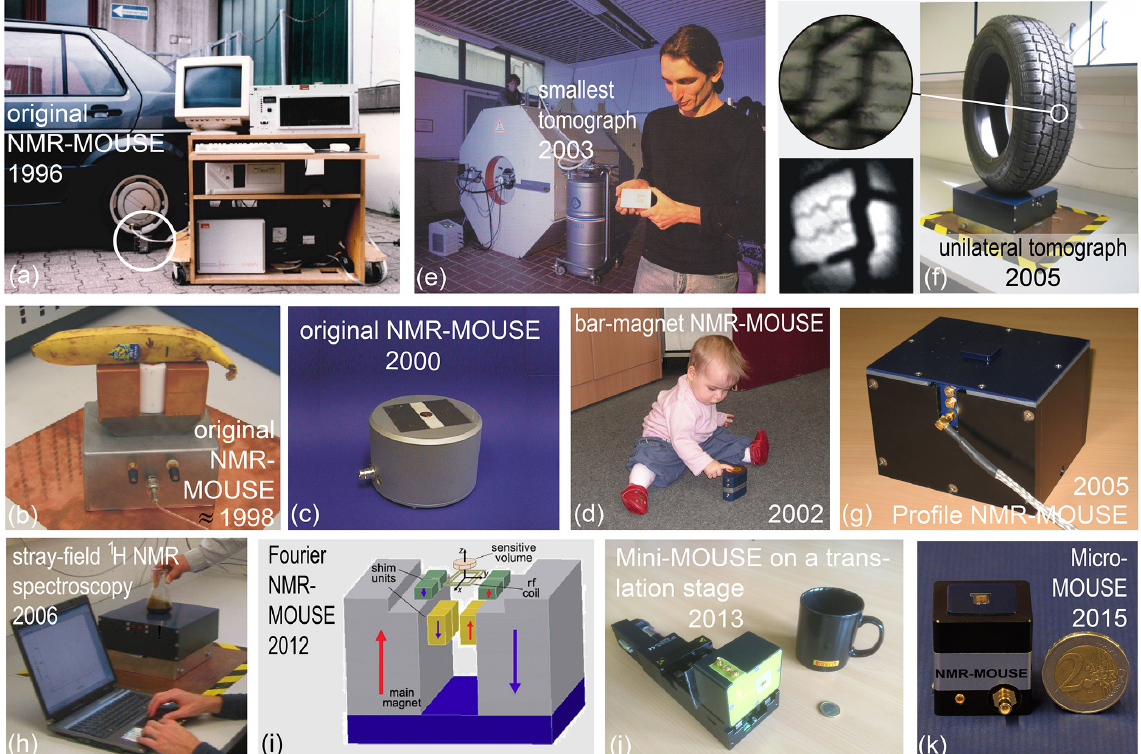
Figure 2. The evolution of stray-field NMR at RWTH Aachen University. (a) The original NMR-MOUSE measuring a car tire. (b) An early version of the NMR-MOUSE with copper-shielded magnets for dead-time reduction. (c) The original NMR-MOUSE in 2000. (d) The bar- magnet NMR-MOUSE is the simplest construction of a stray-field NMR sensor. (e) In 2003 Juan Perlo developed the smallest tomograph in stray-field technology (photo: Peter Winandy). (f) A single-sided tomograph with a flat imaging plane. Right: setup for mapping a tire tread. Left: a photo (top) in comparison with an MR image (bottom). (g) The Profile NMR-MOUSE with a flat sensitive slice developed in 2005. (h) Stray-field NMR magnet capable of measuring chemical-shift-resolved 1 H NMR spectra from a fluid in a beaker placed on top of the magnet. (i) Fourier NMR-MOUSE with shim magnets producing a 2mm thick sensitive slice for frequency encoding of depth. (j) Mini-MOUSE with a multilayered micro-coil having a dead time of 10µs. (k) Micro-MOUSE constructed from four 1cm 3 permanent magnet